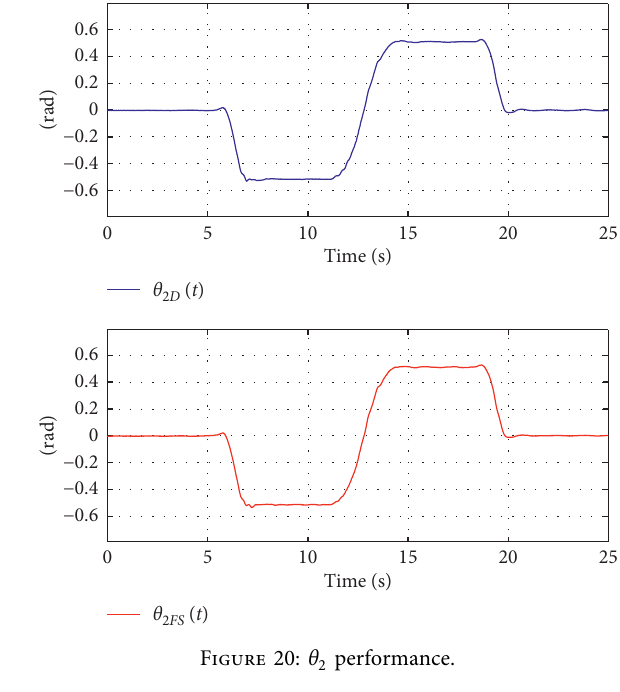
Figure 18: Tracking error.